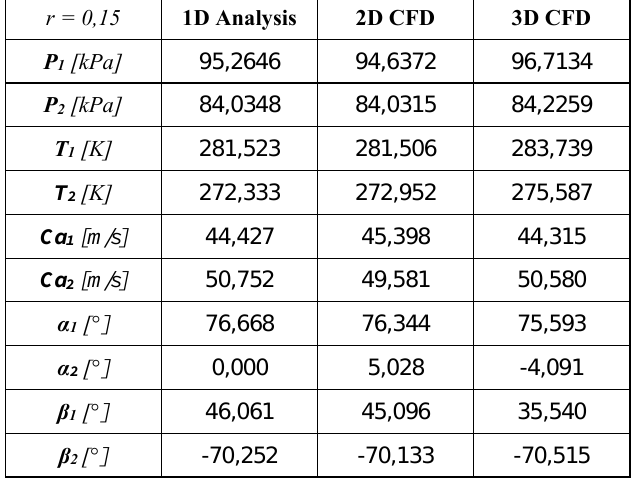
Table 2. Results on the hub end wall (r = 0,15 m).